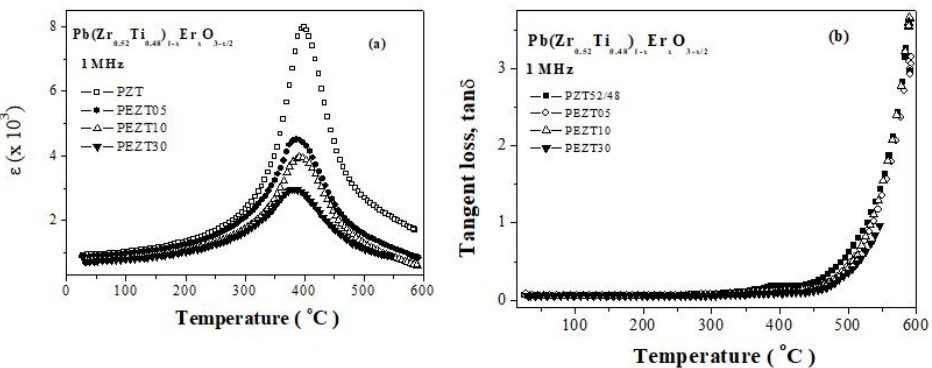
Figure 5. (a) Behavior of dielectric constant (ε) of PZT52/48 and PEZTs´ with temperature at 10 6 Hz, (b) Variation of tangent loss (tan δ) of PZT52/48 and PEZTs´ with temperature at 10 6